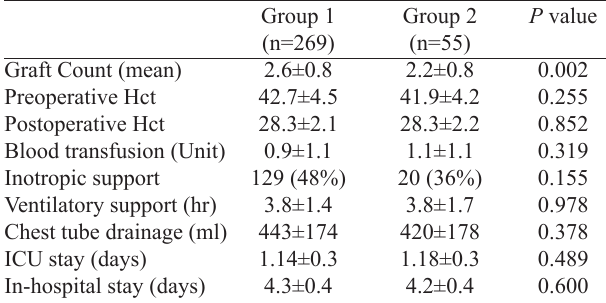
Table 2. Clinic data of the groups.